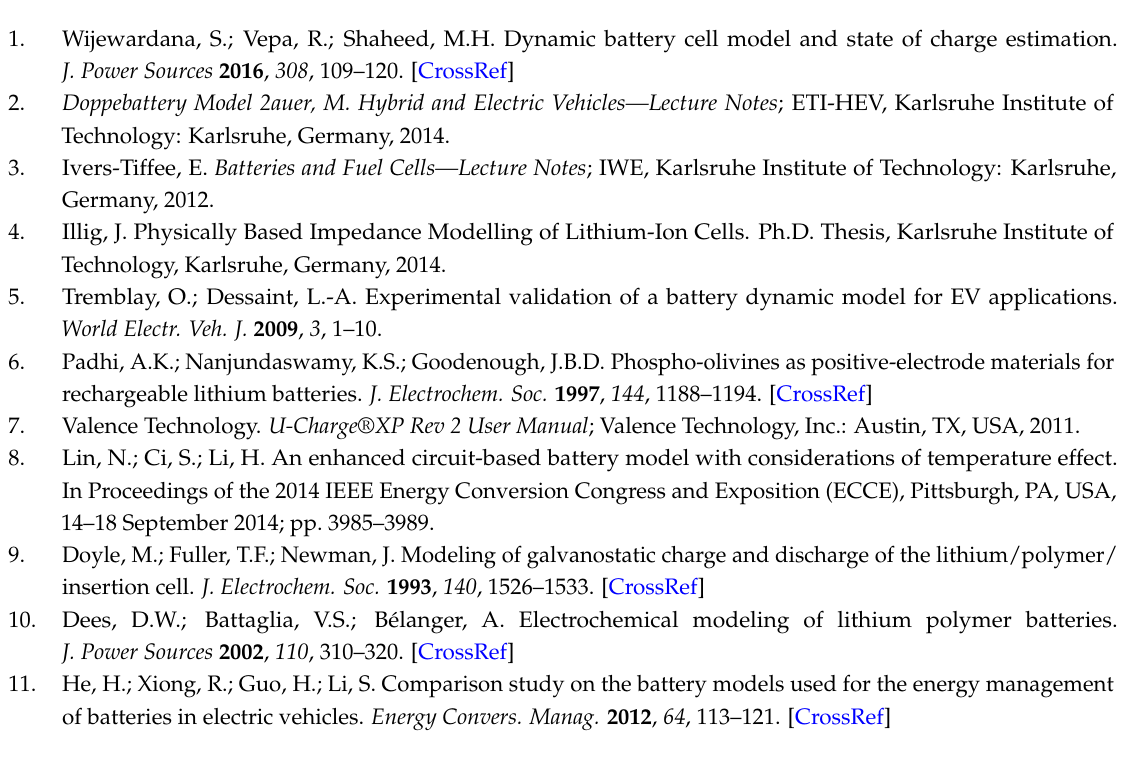
Figure C2. The basic drive train topology of the Mercedes A ‐ Class research vehicle [30]. Figure A4. The basic drive train topology of the Mercedes A-Class research vehicle